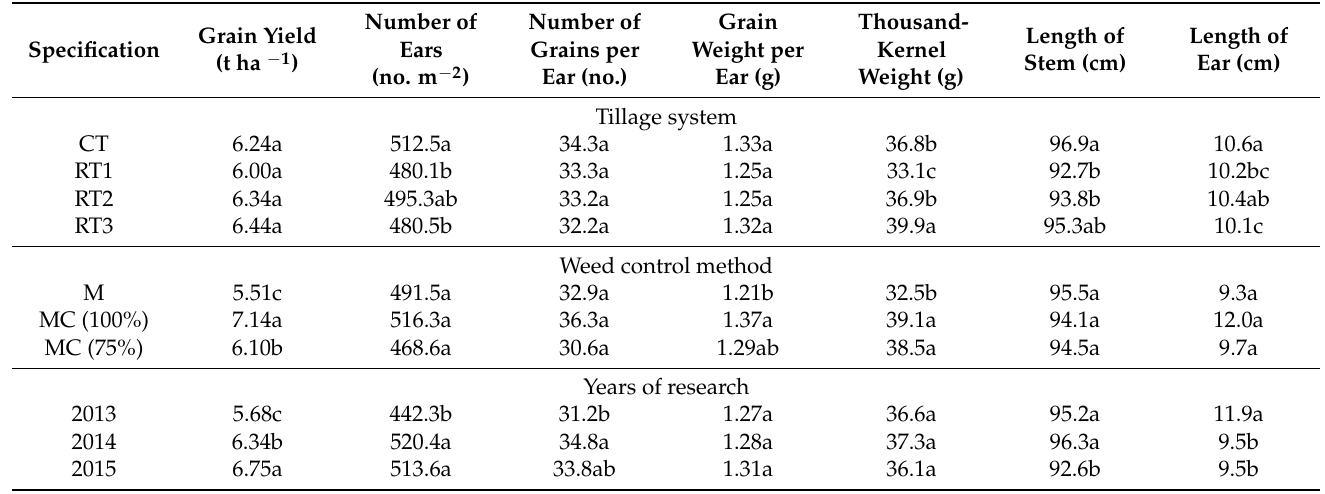
Table 3. Spelt wheat yield and crop and yield components depending on tillage system, weed control method (mean for 2013–2015), and years of